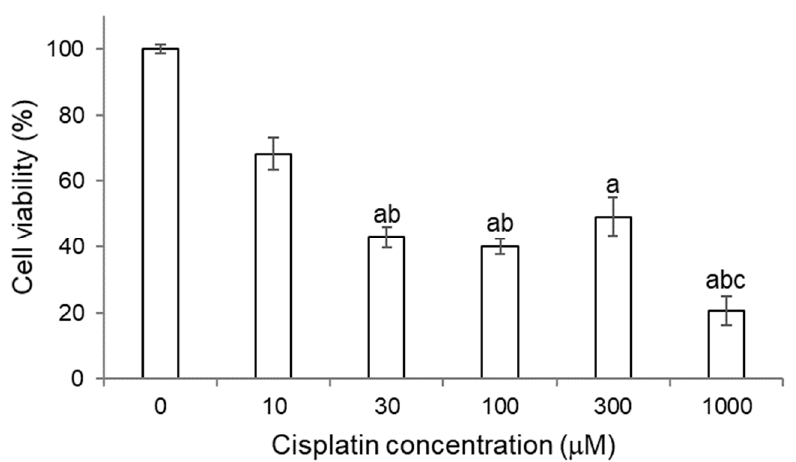
Figure 3. Titration of cisplatin cytotoxicity for 18 h of treatment in HK-2 cells. Cell viability was determined using the MTT assay. Values are expressed as the mean ± SEM. Significant differences ( p < 0.05): a vs. 0 μ M; b vs. 10 μ M; c vs. 300 μ M.